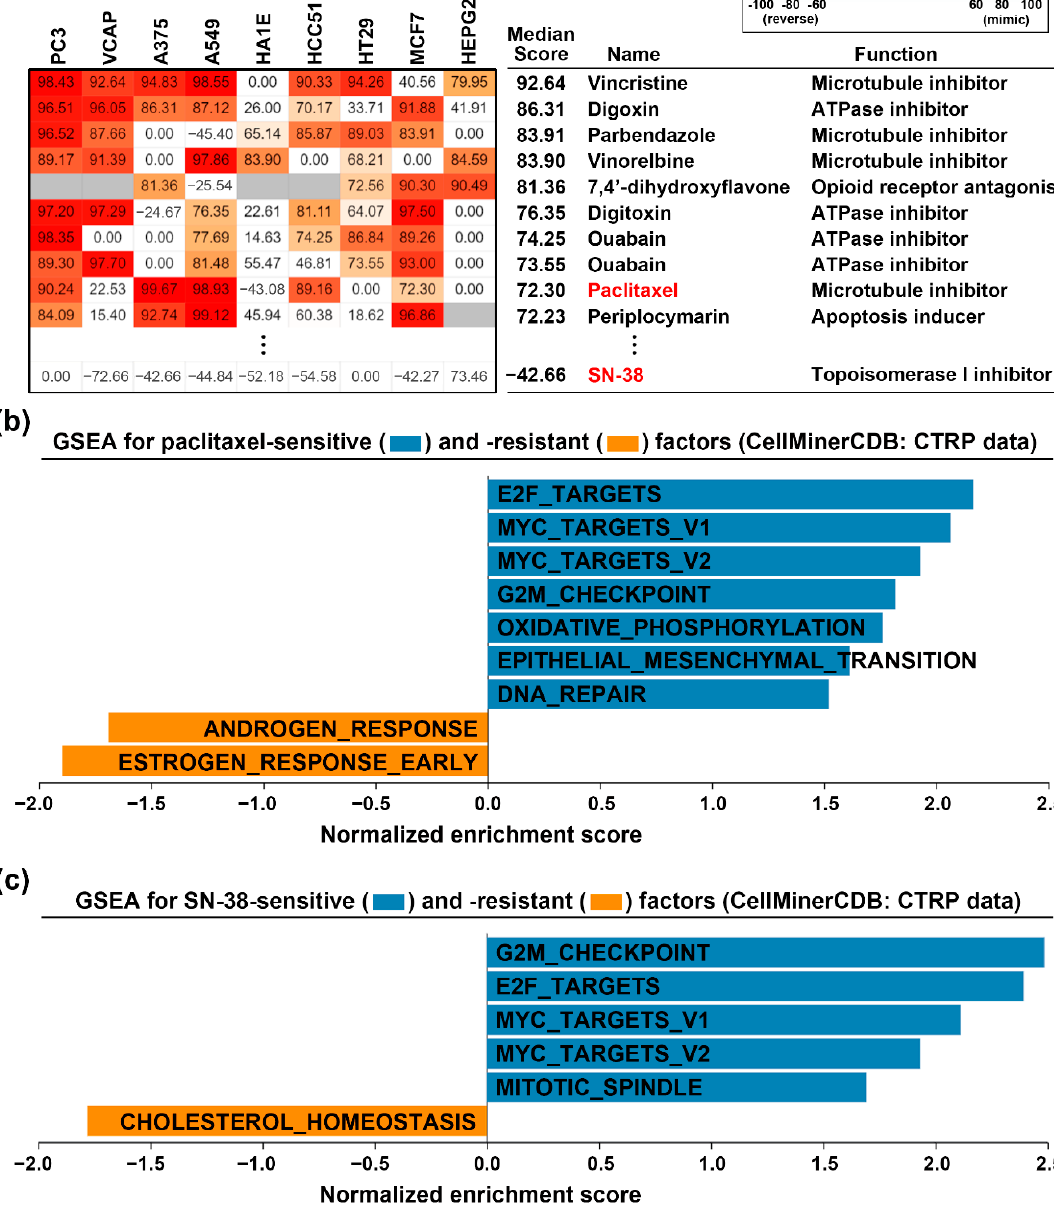
Figure 4. Paclitaxel treatment mimics the e ff ect of CDKN2A restoration. ( a ) CMap analysis was performed to explore the similarity among CDKN2A- and drug-induced gene signatures; ( b , c ) the sensitive and resistant gene factors for paclitaxel ( b ) and SN-38 ( c ) in PDAC cell lines were obtained from the CTRP database via an online tool, the CellMinerCDB. GSEA was performed for these factors against 50 cancer